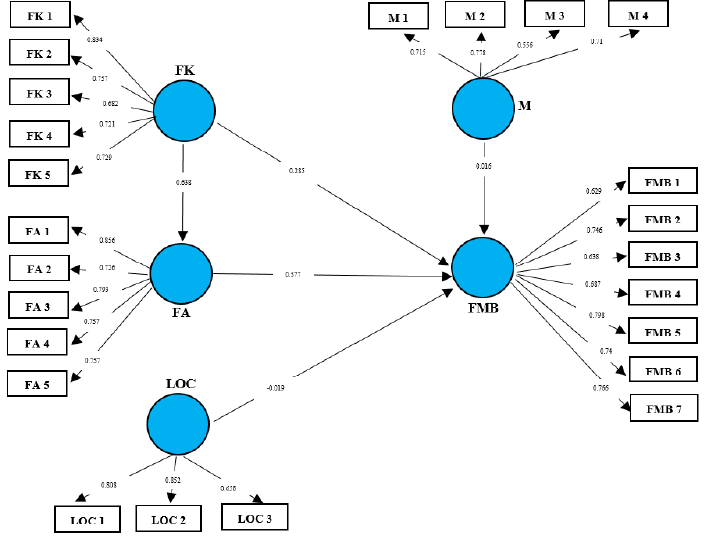
Figure 2. Research Framework with Statistical